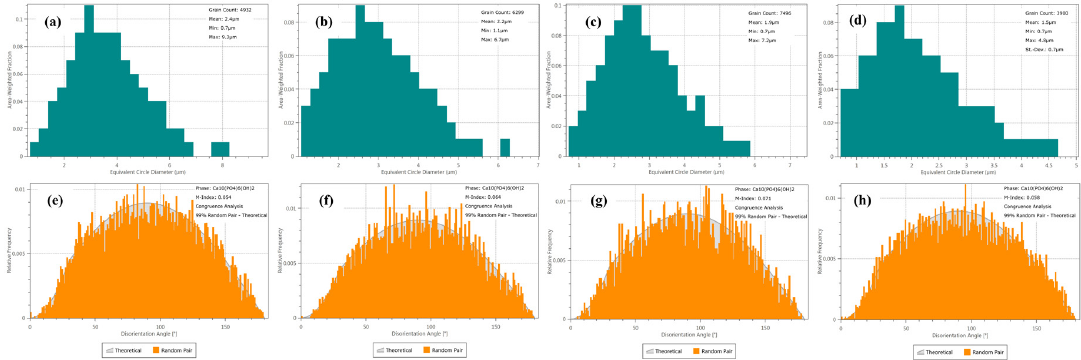
Figure 6. Grain size of HA and orientation distribution of pure HA and ZnO/HA composites: ( a , e ) Pure HA; ( b , f ) Zn 10 wt.%; ( c , g ) Zn 20 wt.%; ( d , h ) Zn 30 wt.%.